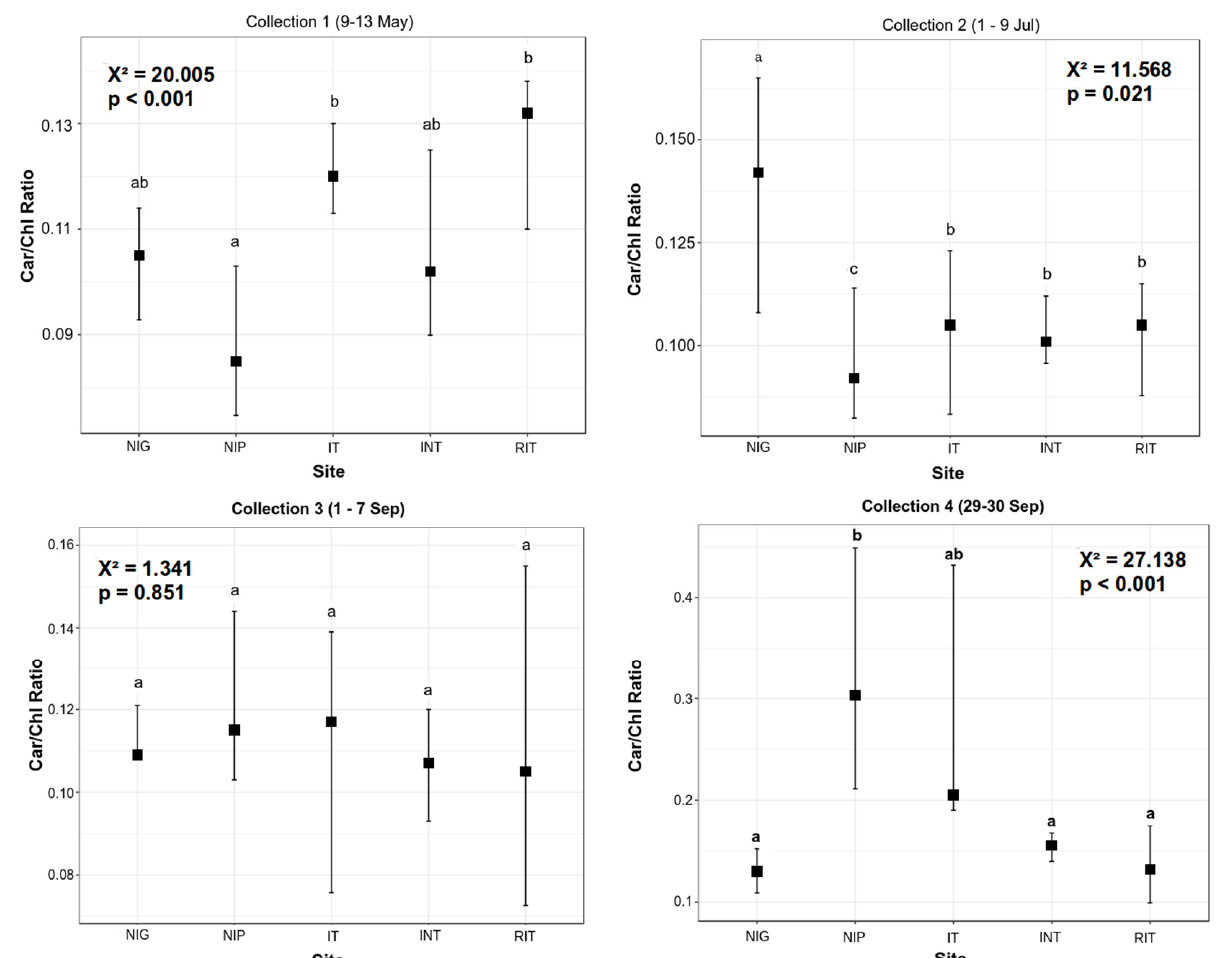
Figure 7. Kruskal–Wallis test results for Car/Chl ratio in 2018. Letters indicate groupings determined by the Conover–Iman test with Bonferroni adjustment. Codes for each site are given in Table 2. Whiskers indicate the range of the data. Note that data ranges were selected to show variation within the data sets, are not uniform between each panel of the diagram.